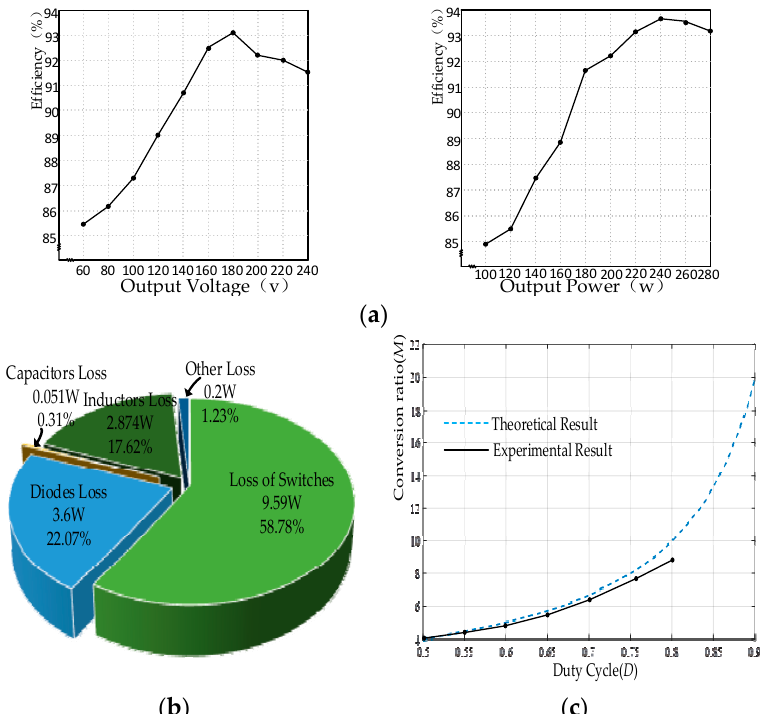
Figure 13. Discharging mode (Boost): ( a ) efficiency curves of the prototype; ( b ) loss distribution of the prototype; ( c ) conversion ratio ( M ) vs. duty cycle ( D ) graph.